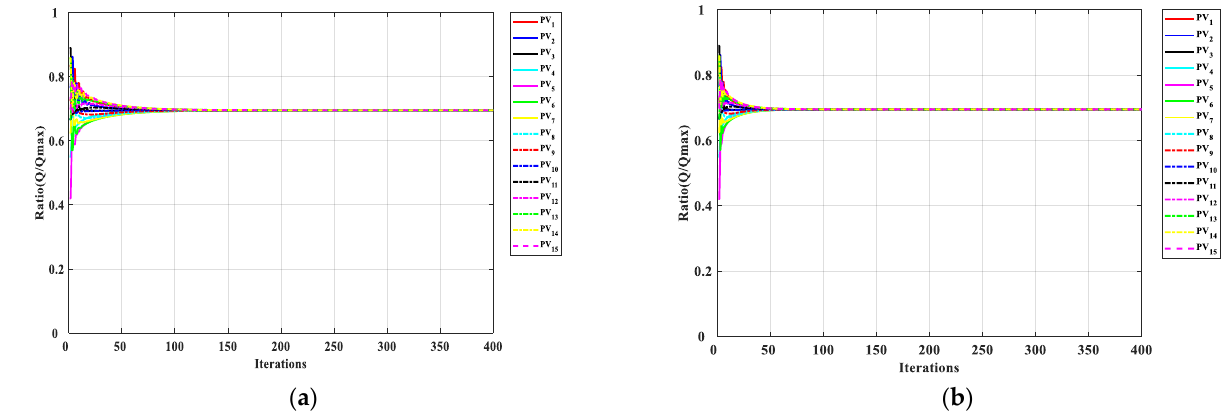
Figure 4. ( a ) q / c ratio result with the ETC. ( b ) q / c ratio result without the ETC.